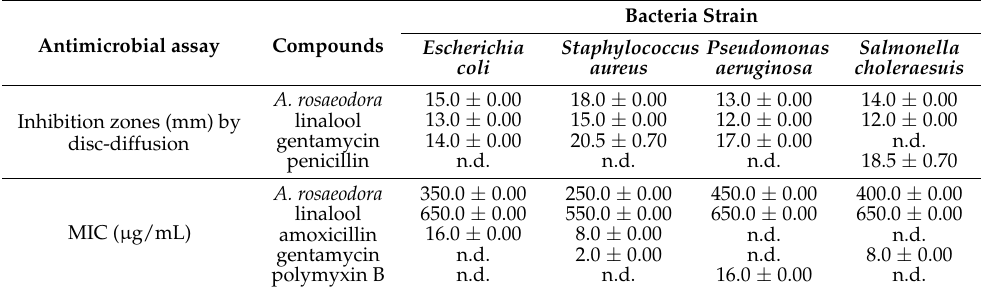
Table 3. Inhibitory zone diameters and minimum inhibitory concentration of Aniba rosaeodora essential oil on different bacterial cultures after 24 h of treatment.